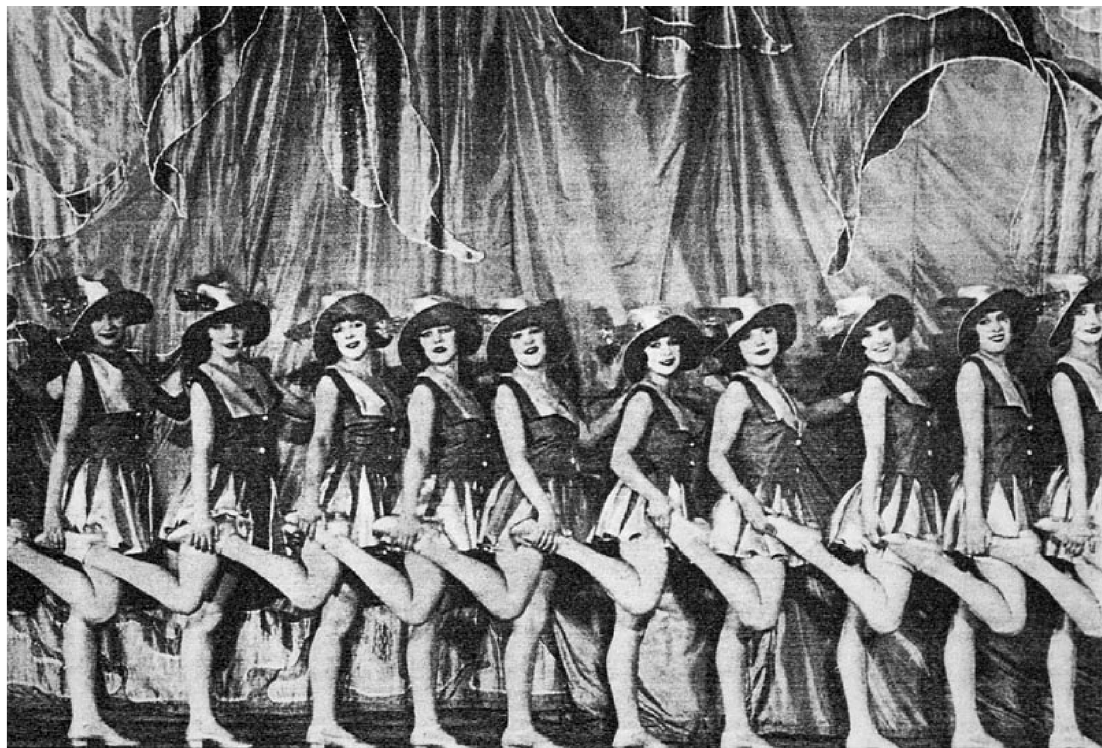
Figure 2. Die Rosy girls in Berlin. Source: Murard and Zylberman (1978, p.